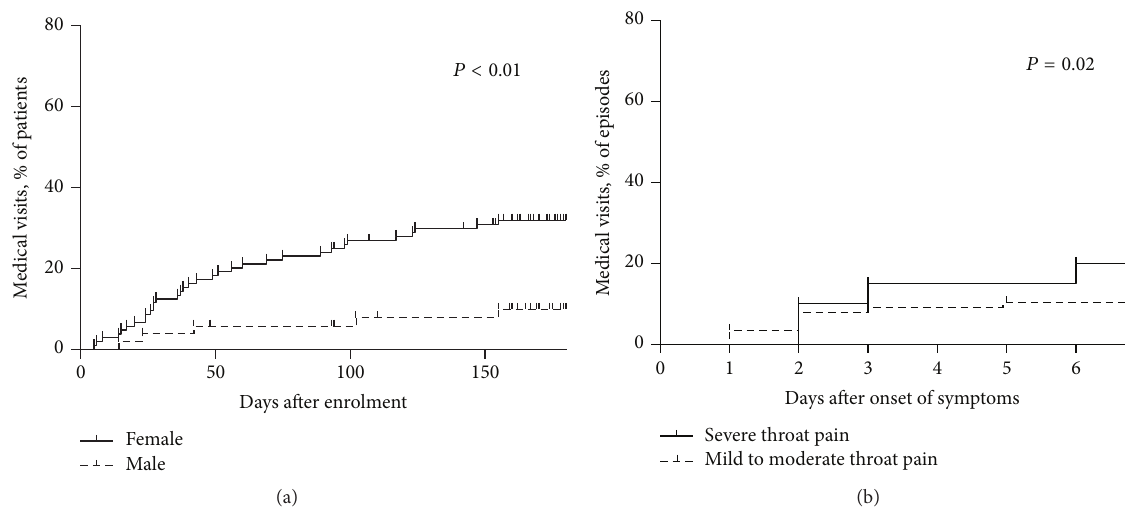
Figure 1: (a) Proportion of adult patients with recurrent pharyngotonsillitis who visited physician for acute pharyngotonsillitis during a follow-up of 6 months according to sex ( 𝑁 = 156 patients, differences between groups tested with log rank test). (b) Proportion of acute pharyngotonsillitis episodes that led to medical consultation during the first 7 days according to whether the patient had had severe throat pain ( 𝑁 = 135 episodes, where data on severity of throat pain was available, differences between groups tested with log rank test).